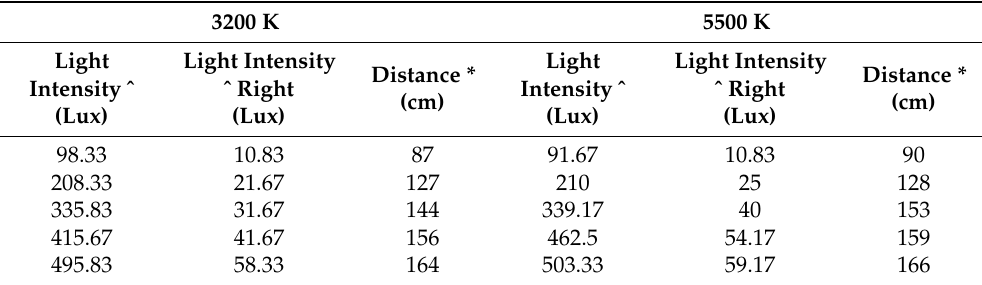
Table 4. Compare the relation among light intensity (Lux), light color (Kelvin), and detection distance (cm) for light source without diffuser from right side.